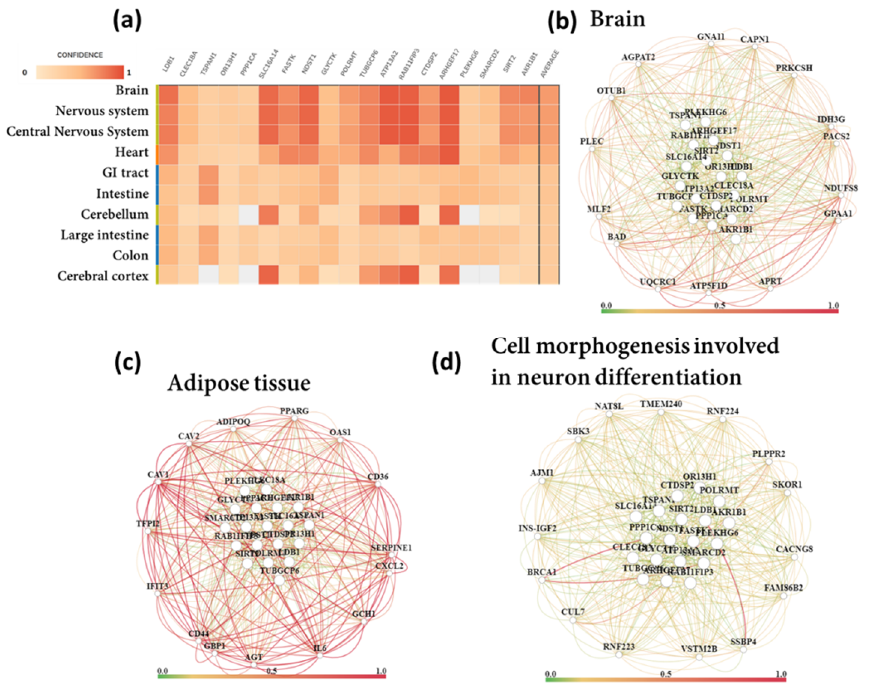
Figure 6. Tissue and biological process-specific functional gene network analysis for top 19 upregulated DEGs. ( a ) Tissue expression, ( b ) brain-specific functional network, ( c ) adipose tissue-specific functional network, ( d ) cell morphogenesis involved in neuron differentiation-specific functional network.